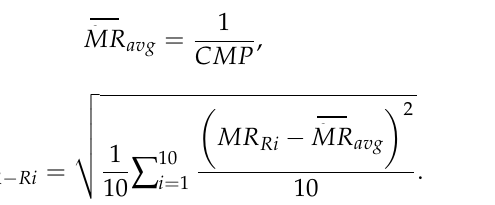
Figure 14. Thermal energy storage for symmetric and asymmetric fin configurations (pitch-24 mm).